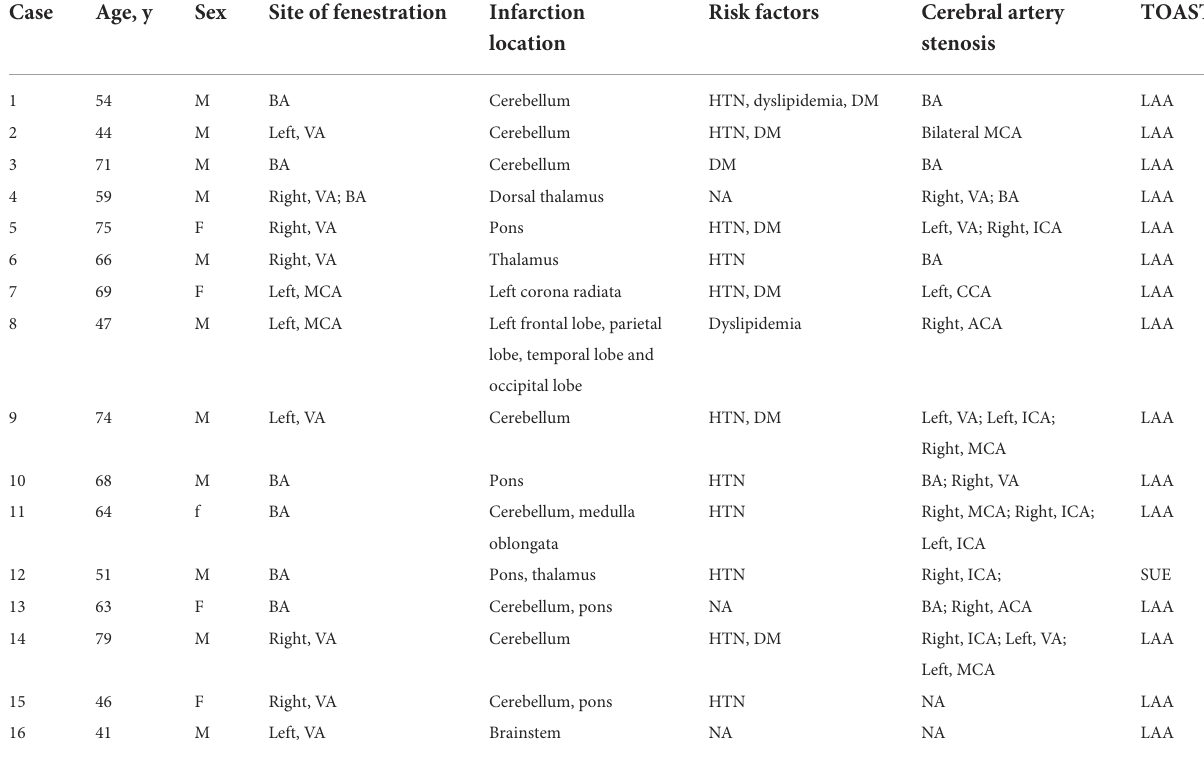
TABLE 2 Demographic and clinical characteristics of patients with fenestration-relevant cerebral infarctions.